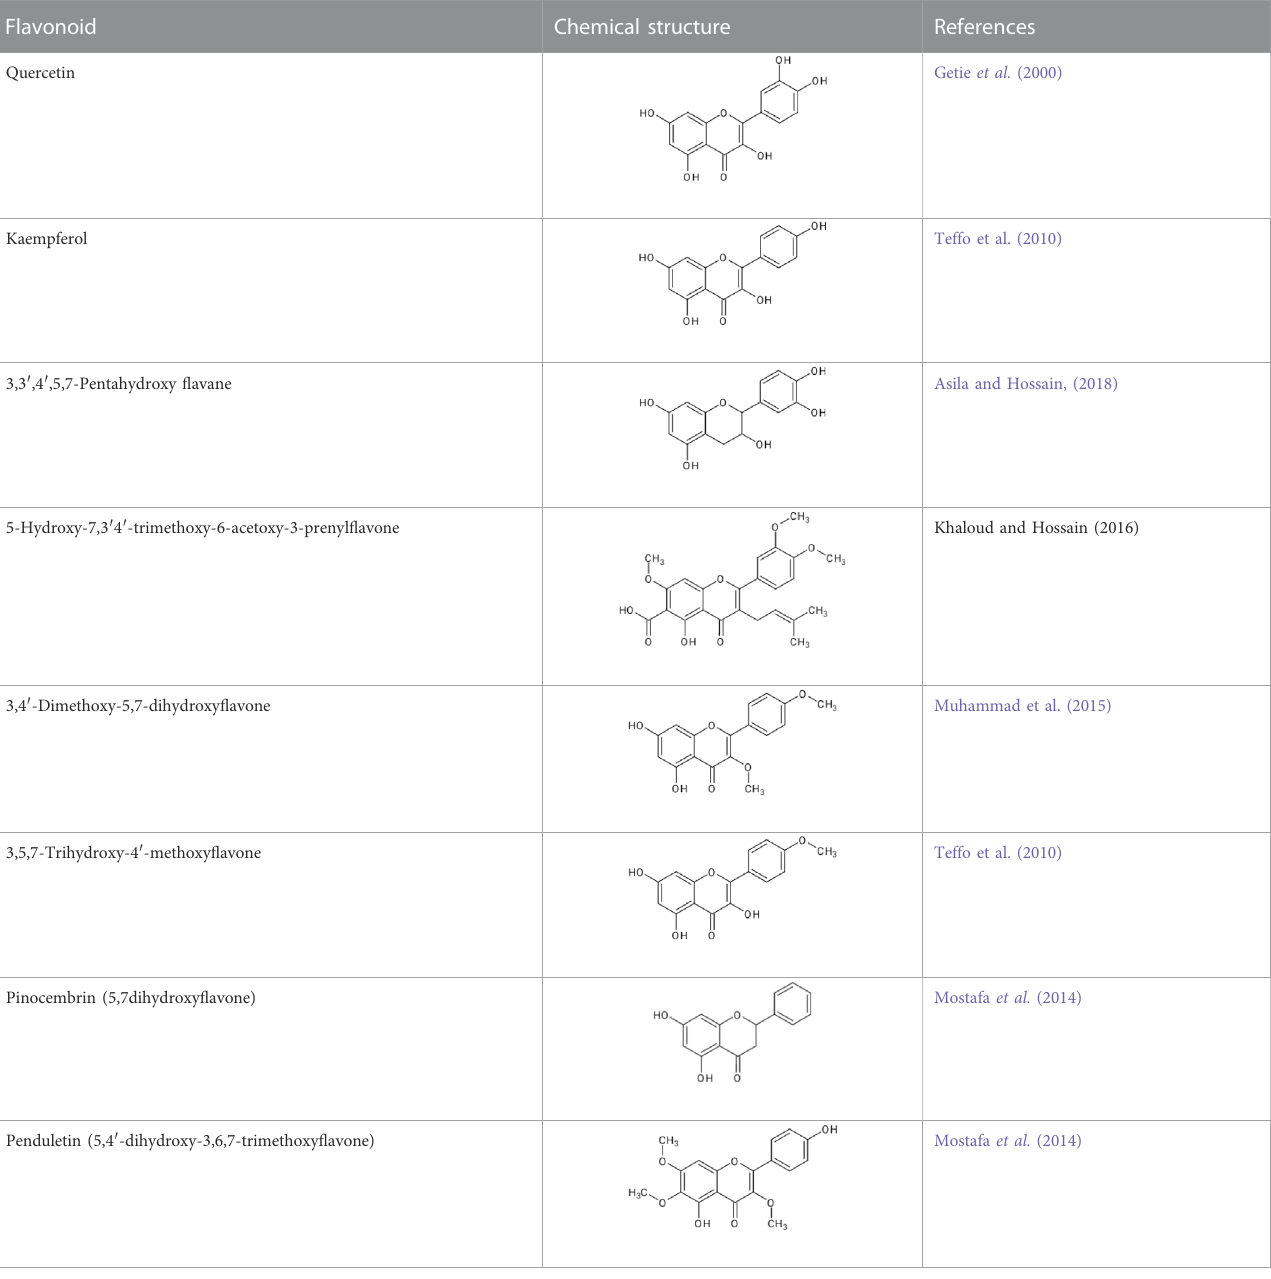
TABLE 1 Reported fl avonoids from D. viscosa . Flavonoid Chemical